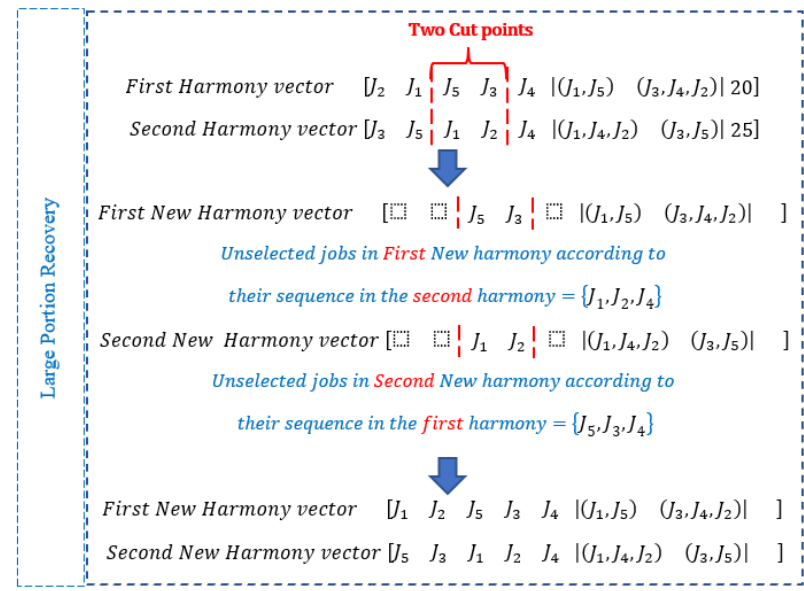
Figure 6. Example of large portion recovery